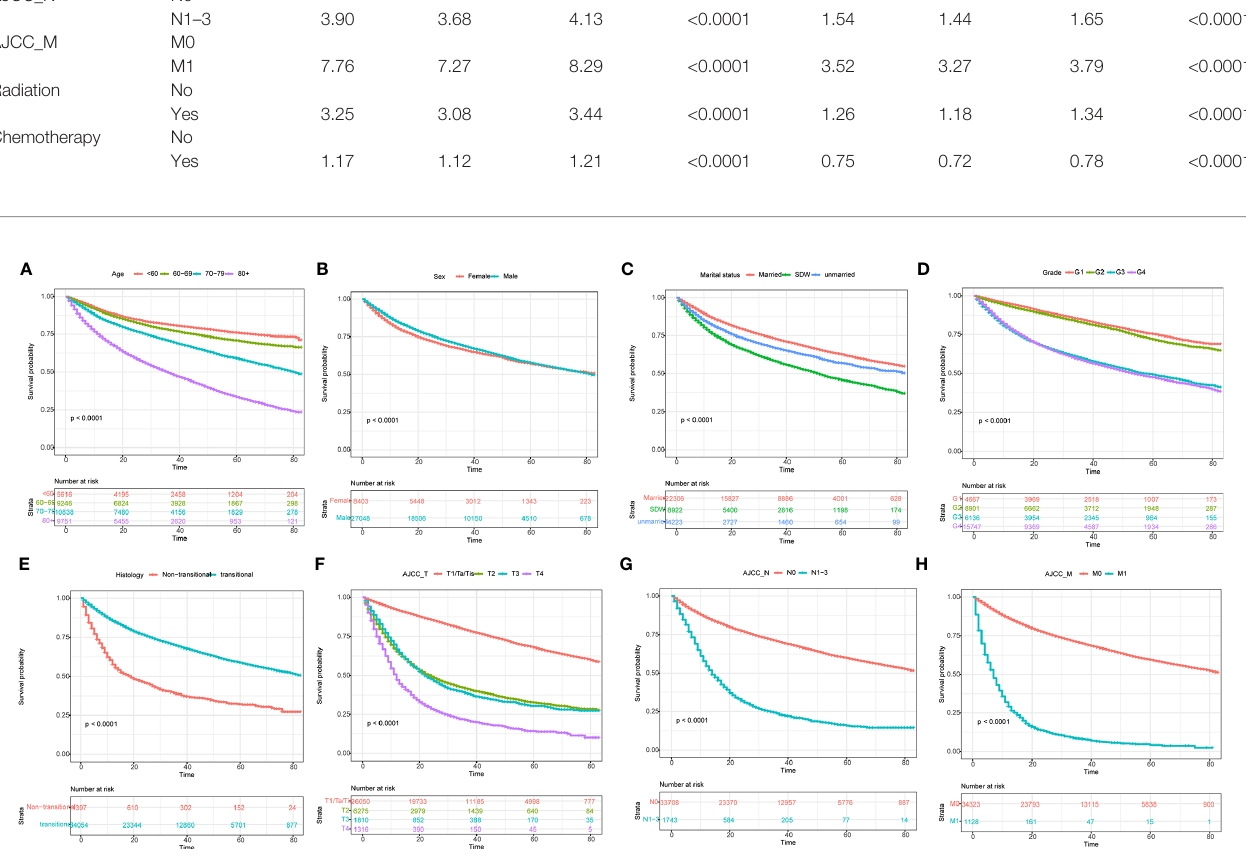
FIGURE 2 | Kaplan – Meier curves for overall survival in BLCA patients on different strati fi cation. (A) age; (B) Sex; (C) marital status; (D) grade; (E) histology; (F) AJCC_T stage; (G) AJCC_N stage; (H) AJCC_M stage. Kaplan – Meier curves with different colors represent survival status on given subgroup, while risk table below the curves records the number of cases at speci fi c follow-up time. All P-values were <0.0001.